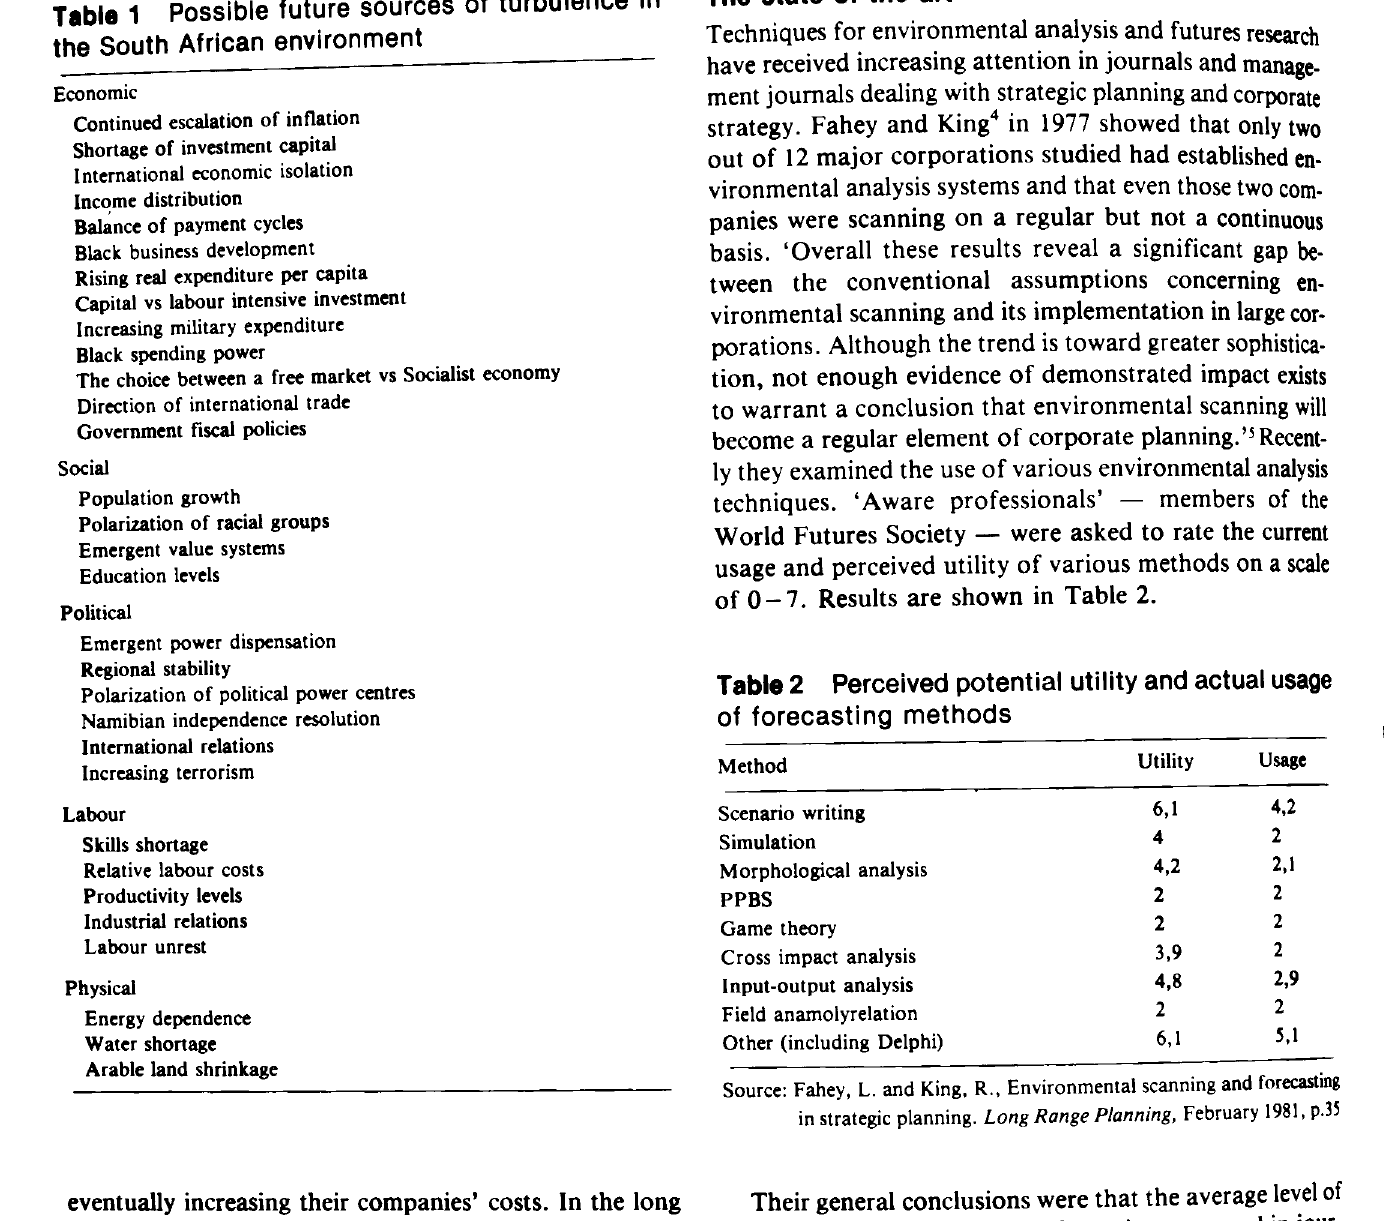
Perceived potential utility and actual